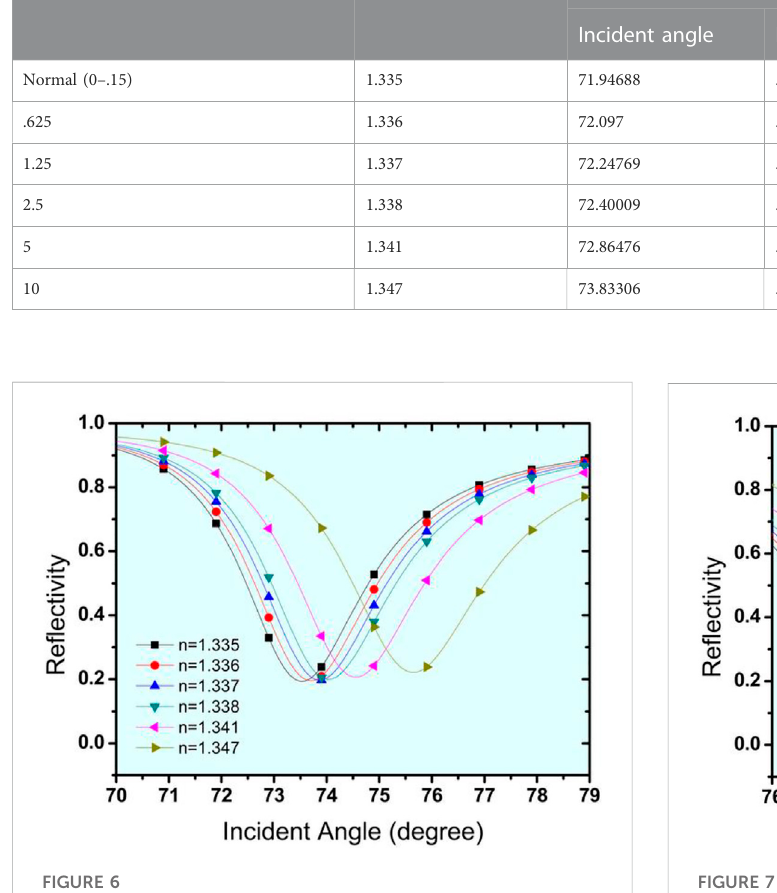
TABLE 3 Angle shift values and re fl ectance on the addition of Si layer for both structure-I and Structure-II. Urine glucose levels (mg/dL)